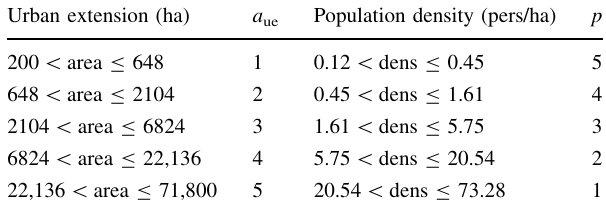
Table 1 Classes and scale for criteria a ue and